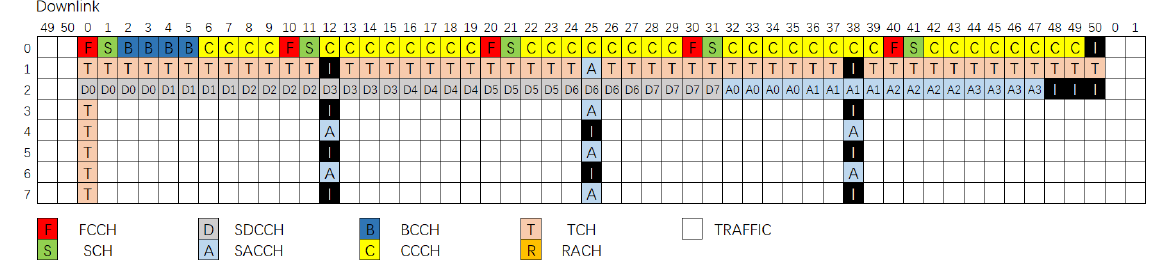
Figure 2. Multi-frame structure on Beacon Channel.